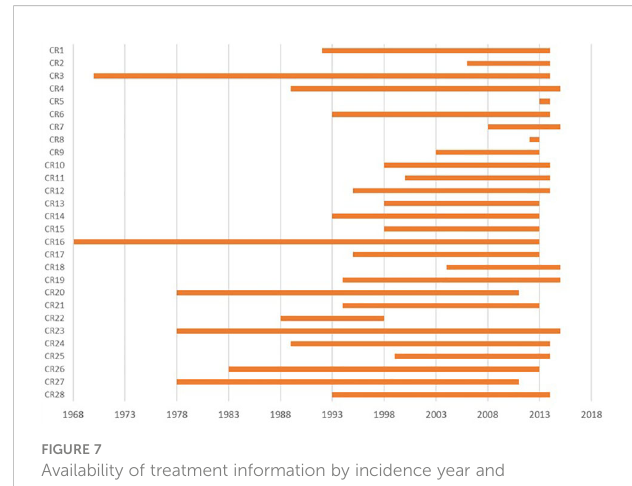
FIGURE 7 Availability of treatment information by incidence year and contributing CR in the ECIS database as of